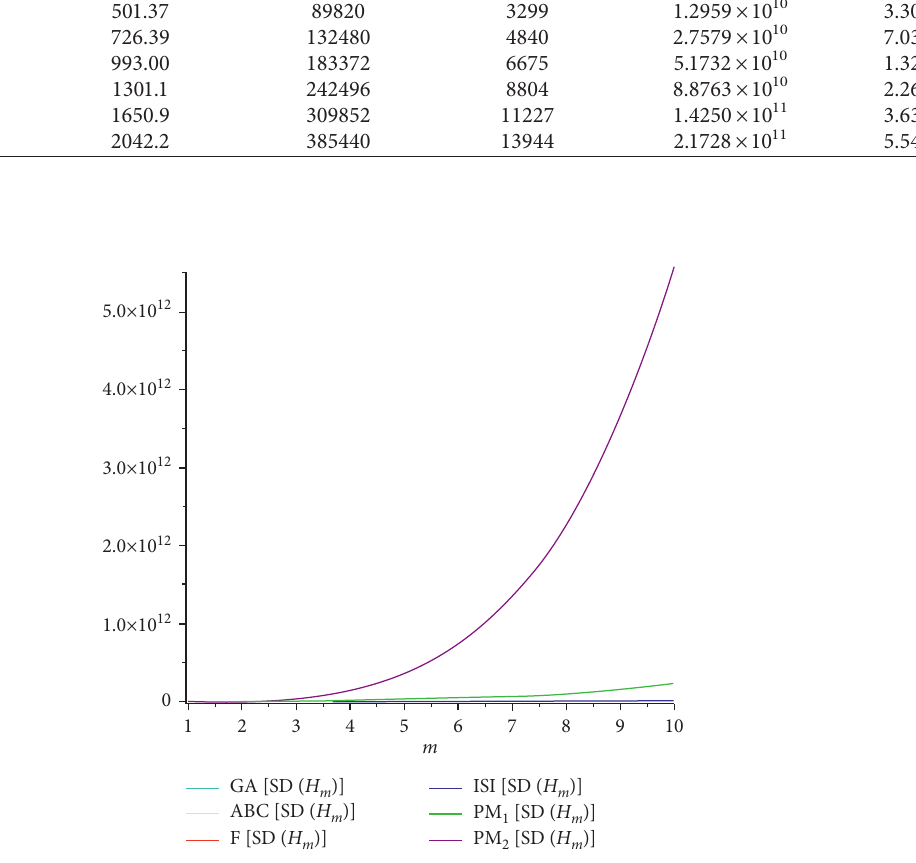
Figure 5: Graphical representation of topological indices of the strong double graph of circumcoronene series of benzenoid ( H